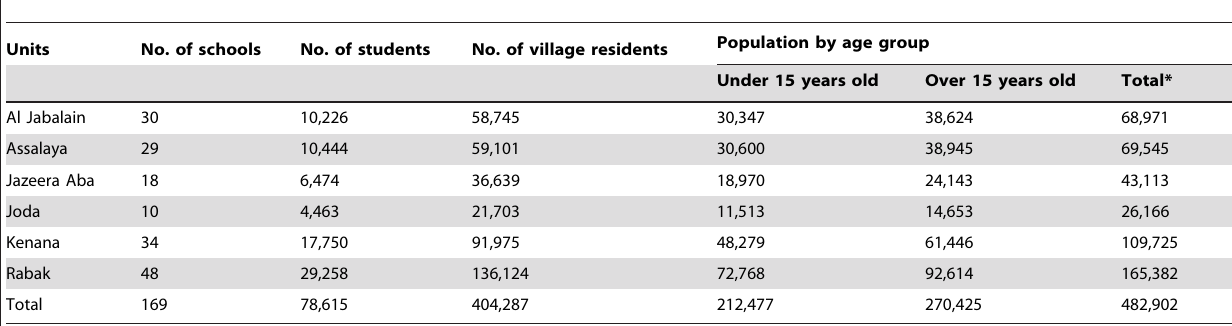
Table 1. Number of students and village residents in the Al Jabalain locality of White Nile State, Sudan.